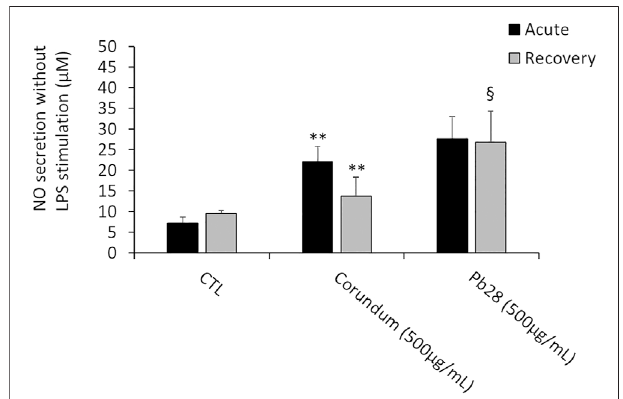
FIGURE8| NOsecretion.Blackbars;acuteexposure(lastdayofculture (cid:1) 24 h). Grey bars; recovery exposure ( fi rst day of culture (cid:1) 24 h) and 9 days recovery post exposure. Data are represented as Mean +SD. Signi fi cance symbols: *, signi fi cant change compared to negative control only (cells without treatment). §, signi fi cant change compared to negative control and corundum control (same concentration). Number of symbols: 1: p < 0.05, 2: p < 0.01 (Student t test, N (cid:1)